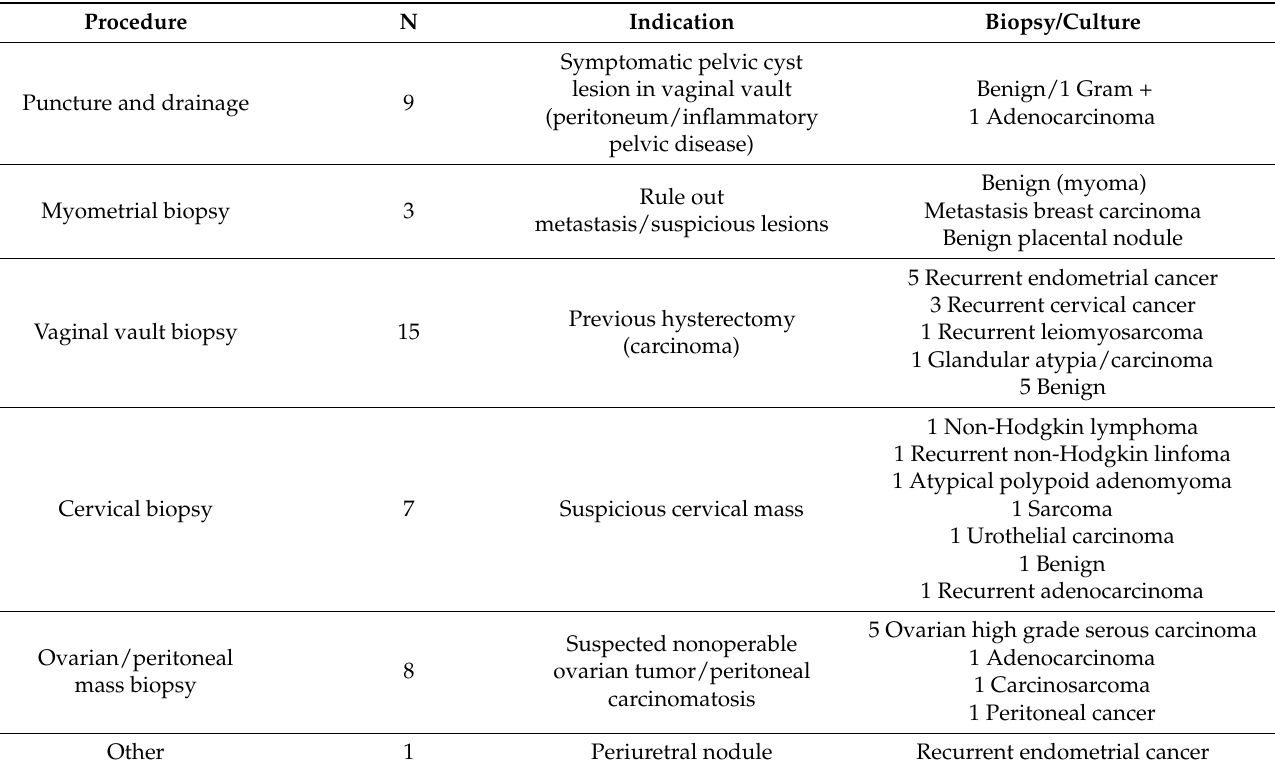
Table 3. Description of the procedures